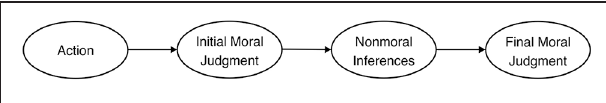
FIGURE 3 | Knobe’s moral pervasiveness